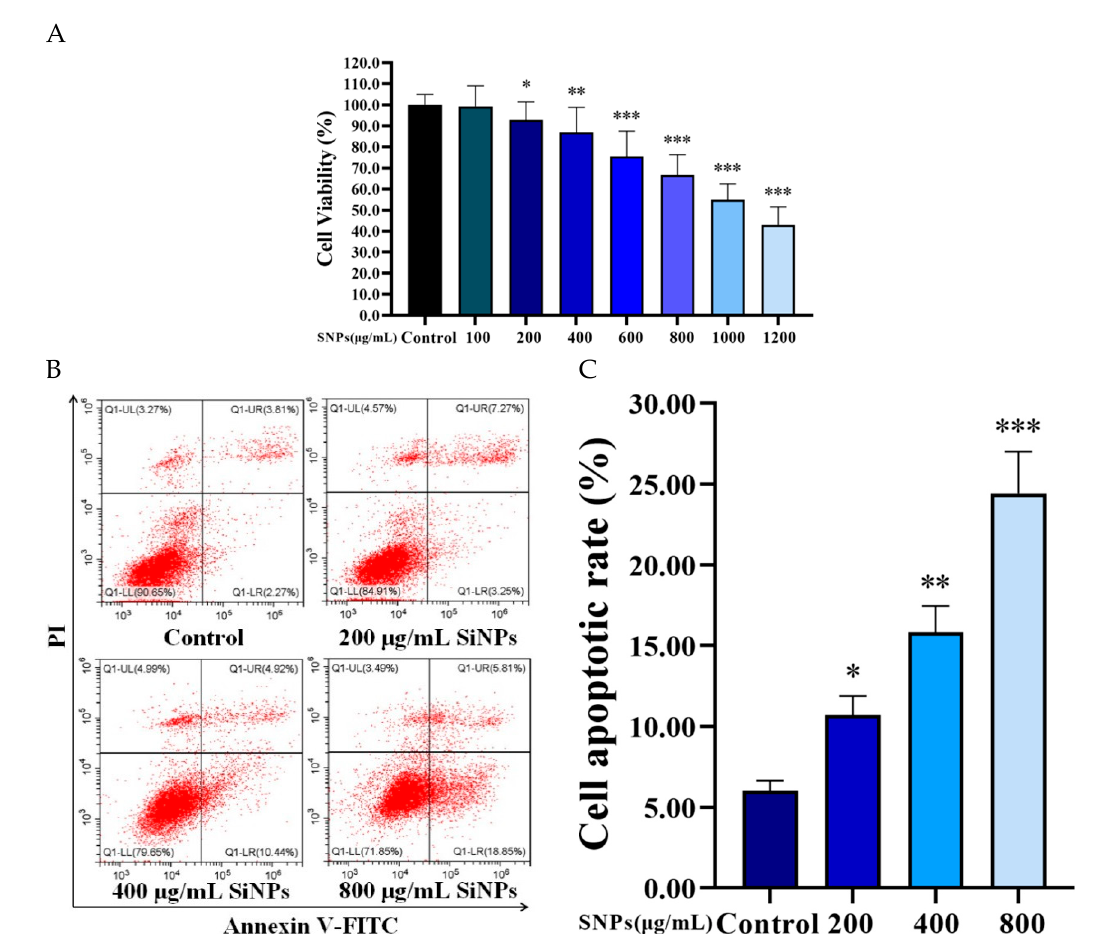
Figure 4. Effect on the viability and apoptosis after SNP treatment. ( A ) Cell viability was deter- mined by CCK-8. The PLCs were treated with control, 100, 200, 400, 600, 800, 1000, and 1200 µg/mL SNPs for 24 h. ( B ) The apoptotic rate was detected by flow cytometry. The PLCs were treated with control, 200, 400, and 800 µg/mL SNPs for 24 h. ( C ) Quantification and statistical analysis of the apoptotic rate. Note: * p < 0.05, ** p < 0.01, and *** p < 0.001 compared to the control.